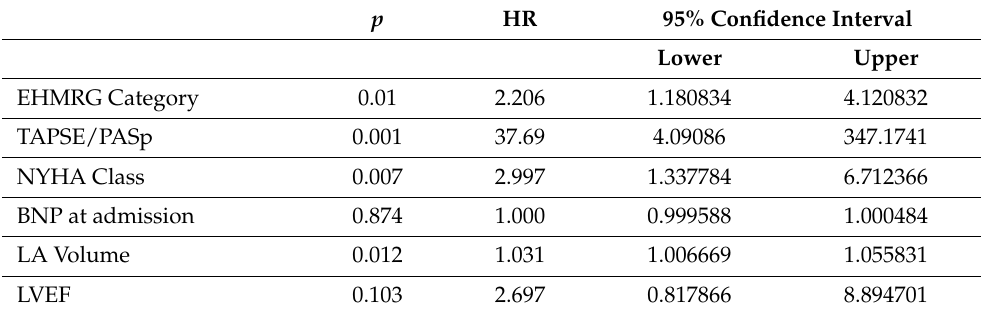
Table 3. Cox regression analysis